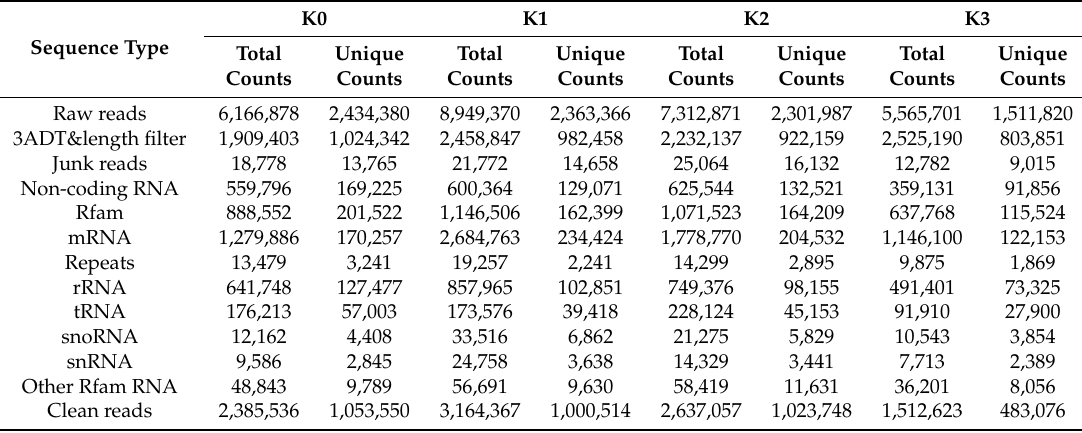
Table 1. Overview of sequencing reads from raw data to cleaned sequences in four